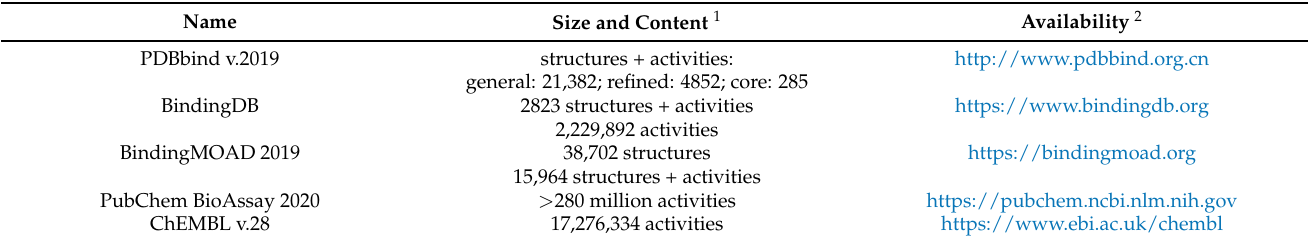
Table 1. Structure and bioactivity data sets. The table lists common labeled data sets used in virtual screening studies. Freely available data is increasing each year and is an essential element for affinity prediction using machine and deep learning models. The table summarizes the name, the size and the content covered as well as links to the respective